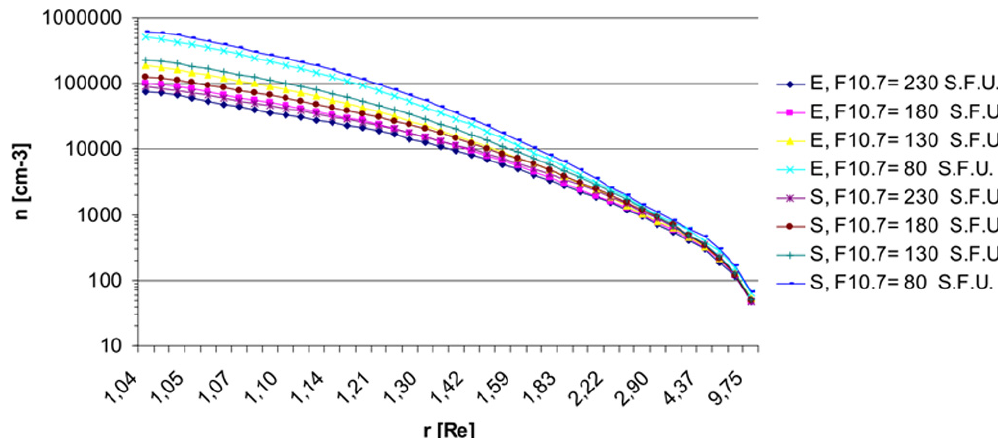
Fig. 8. Hydrogen density versus radial distance and radio solar flux at equinox (E) and solstice (S) at midnight with the exospheric H model from Hodges.